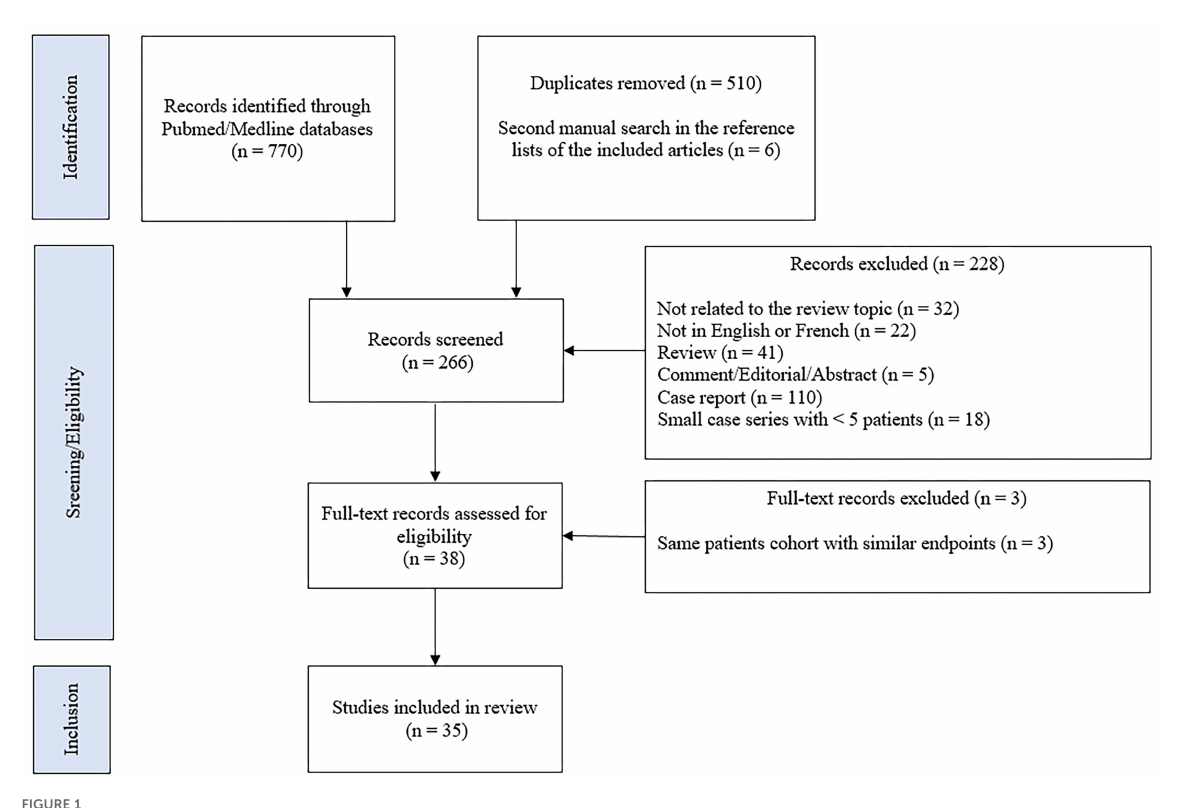
FIGURE1 Flow diagram of included